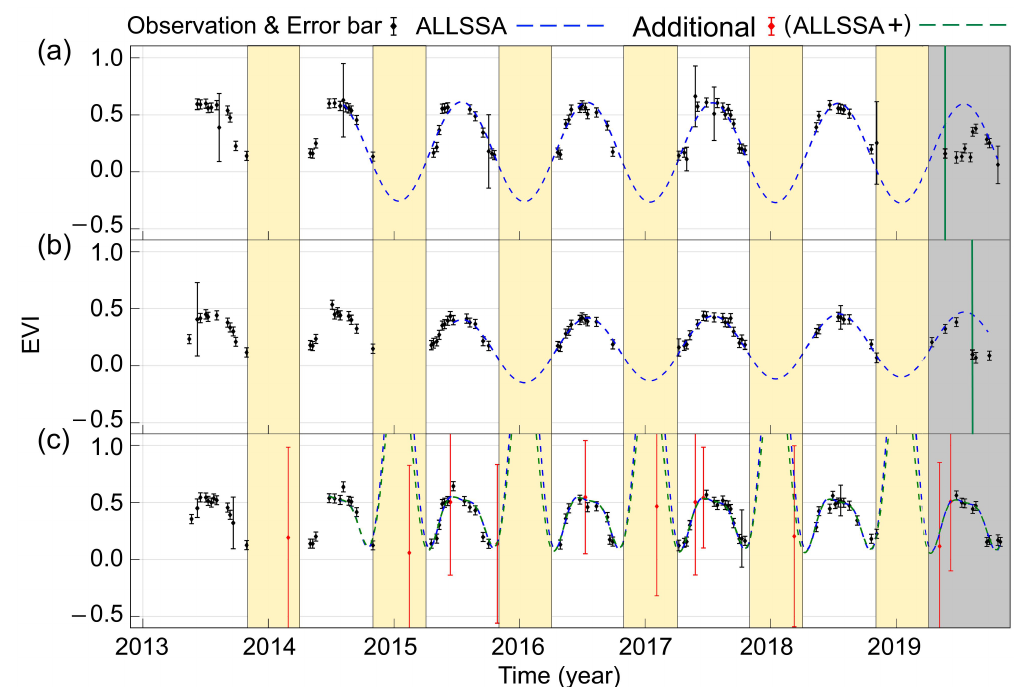
Figure 8. The near-real-time change detection results for pixels A, B, and C displayed in Figure 7. The history period is from 2013, and the expected values (forecast) in MP (April–November, 2019; gray background), using the observations in SHP, are shown with blue dashed lines. The green vertical lines in panels ( a , b ) show the detected disturbances after one and four observations in MP, respectively. The observational uncertainties are shown by the black bars. The periods with large data gaps have yellow backgrounds. The green dashed lines in panel ( c ) show another season-trend fit when all Landsat 8 images are considered, denoted by “ALLSSA + ” in the legend. The additional observations are in red with relatively much larger error